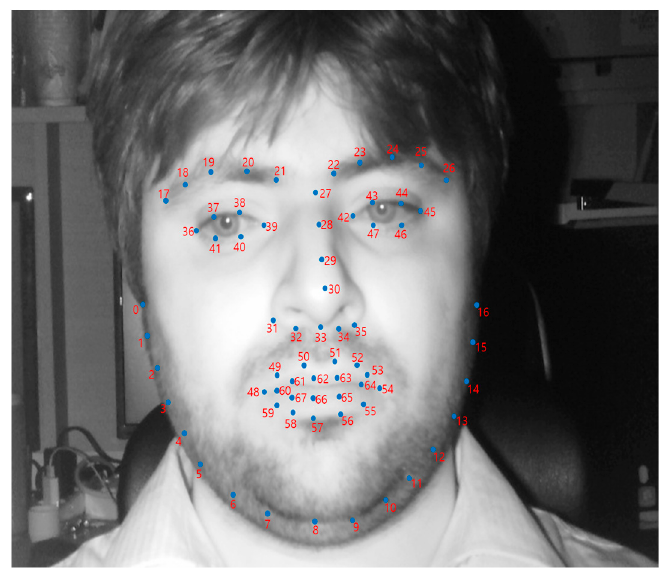
Figure 3. Examples of the captured images of near-infrared (NIR) camera. Remote Sens. 2020 , 12 , x FOR PEER REVIEW